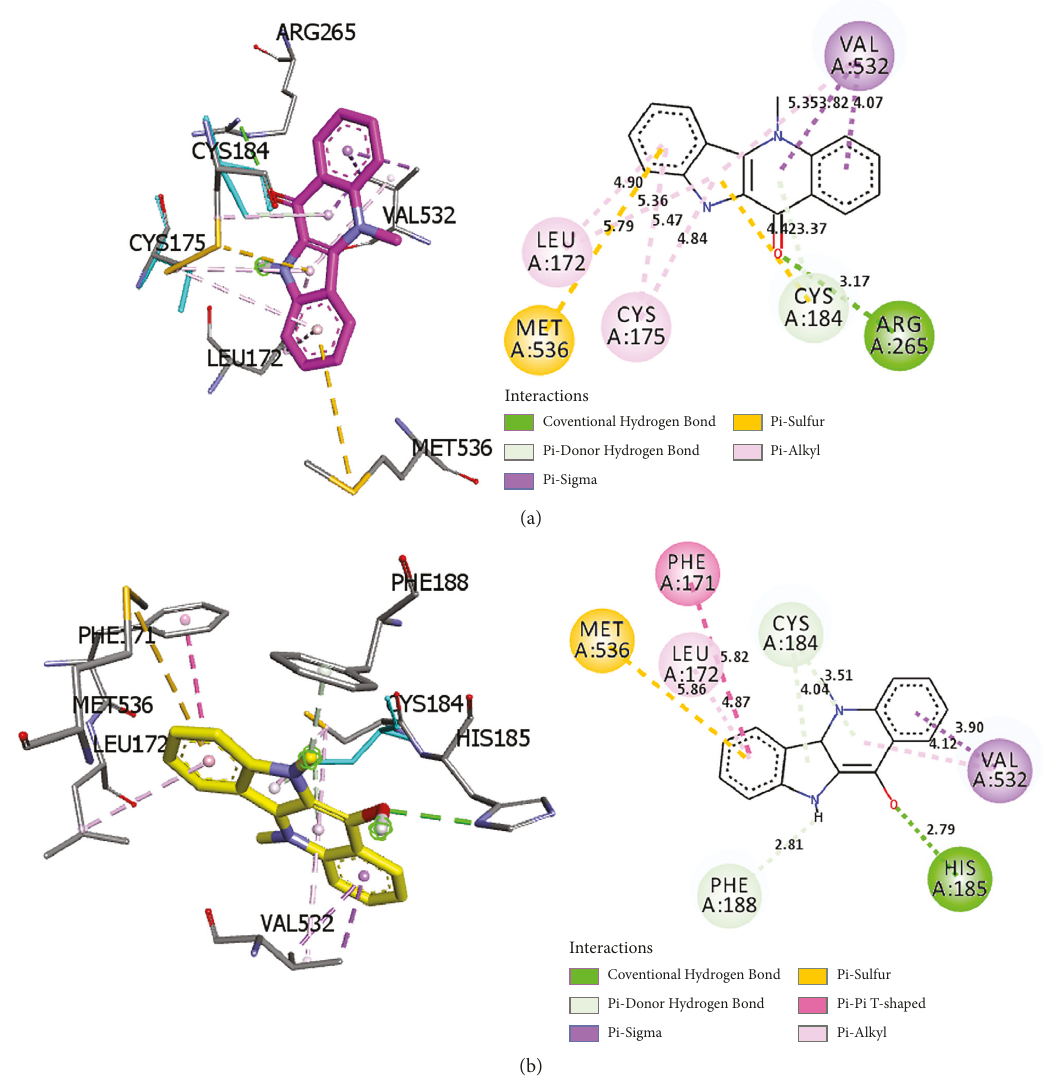
Figure 7: Interactions of some alkaloids with Pf DHODH: 3D (left) and 2D (right) views of interactions of (a) cryptolepinone and (b) hydroxycryptolepine with residues in the binding region of Pf DHODH (1TV5). Description of interactions is provided under 2D